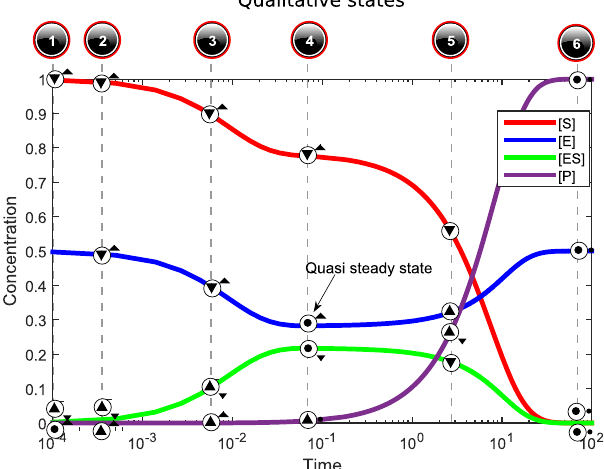
Figure 1. Simulation results for an enzymatic reaction in logarithmic time. The top row shows corresponding qualitative states, produced by simulating a QR model. Value histories of the quantities are placed on top of the simulation curves. Characteristic states are: initial state 1 (substrate starts being complexed with enzyme), state 4 (quasi-steady state), and end-state 6 (substrate conversion